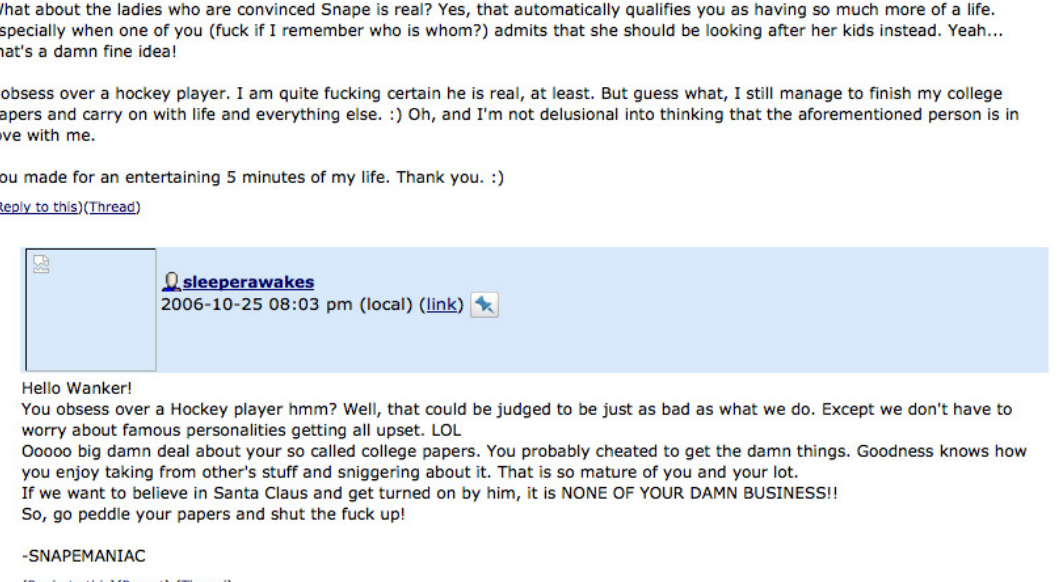
Figure 4. Screenshot of discussion between Tonya and anonymous